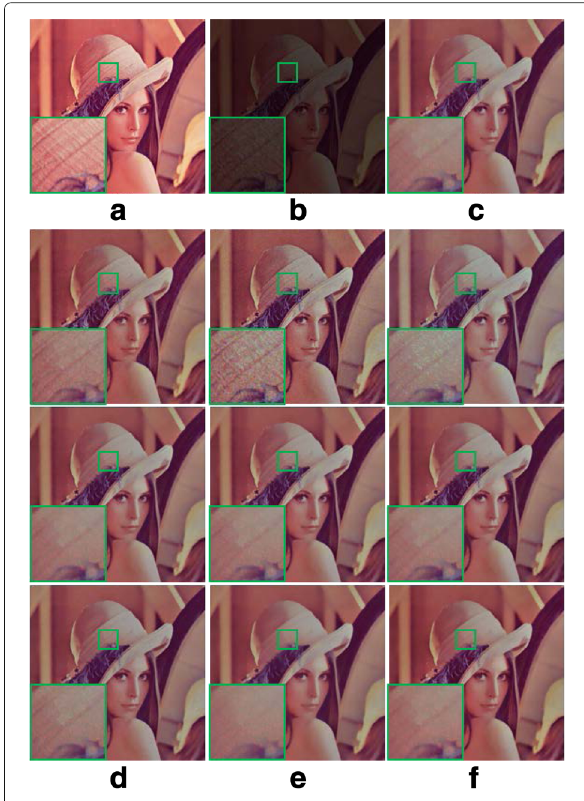
Fig. 3 Experimental results using various sets of regularization parameters: a input image; b simulated low-light image; c resulting image with λ 1 = 300, λ 2 = 0.1, λ 3 = 0.9, and ω = 10; d resulting image set with different λ 1 ; e resulting image set with different λ 2 ; and f resulting image set with different λ